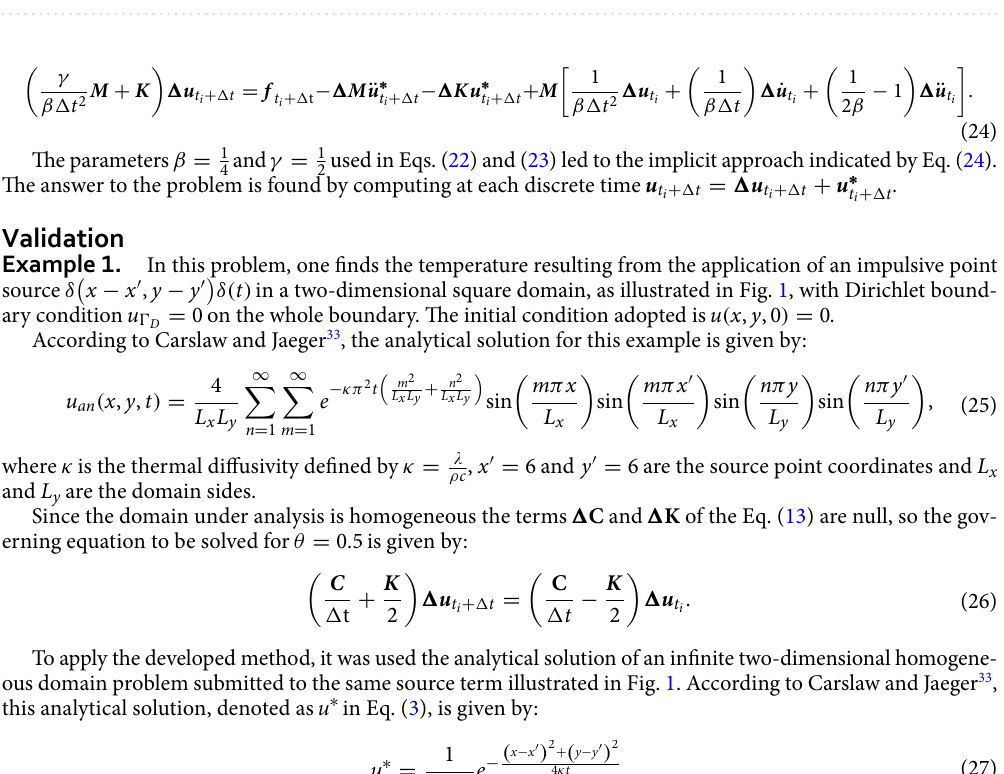
Figure 1. The problem solved in example